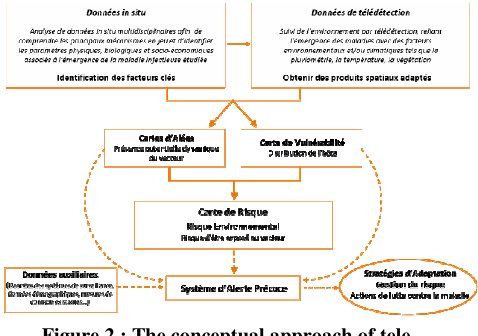
Figure 2 : The conceptual approach of tele-